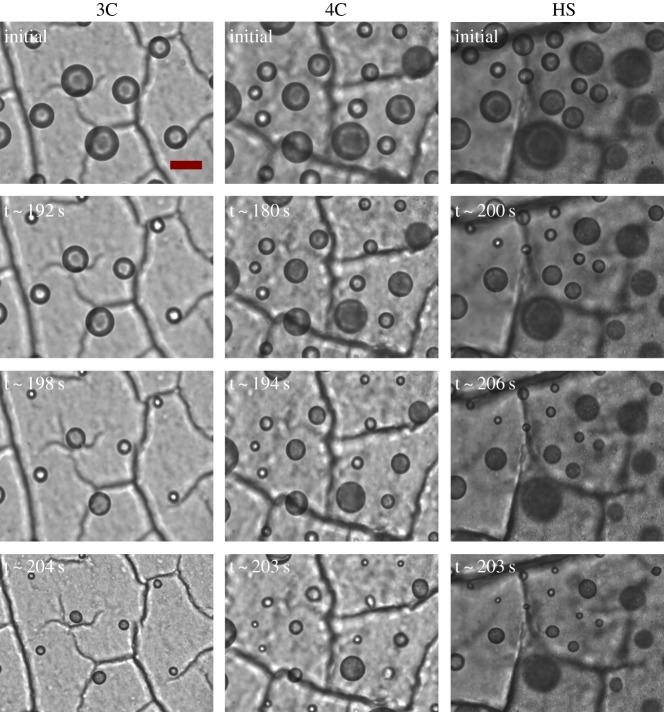
Representative bright-field optical images of evaporating droplets containing different components exposed at constant RH of 60%. Scale bar represents 20 µm. (Online version in colour.)